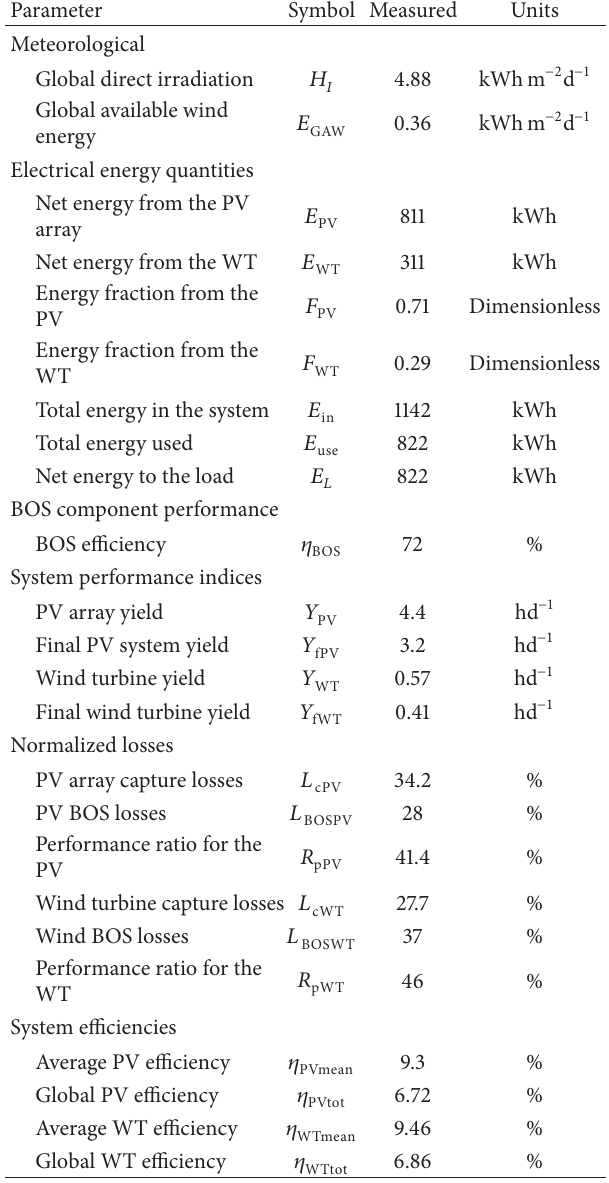
Table 4: Results measured and calculated according to IEC 61724 for January 2009 to January 2010.